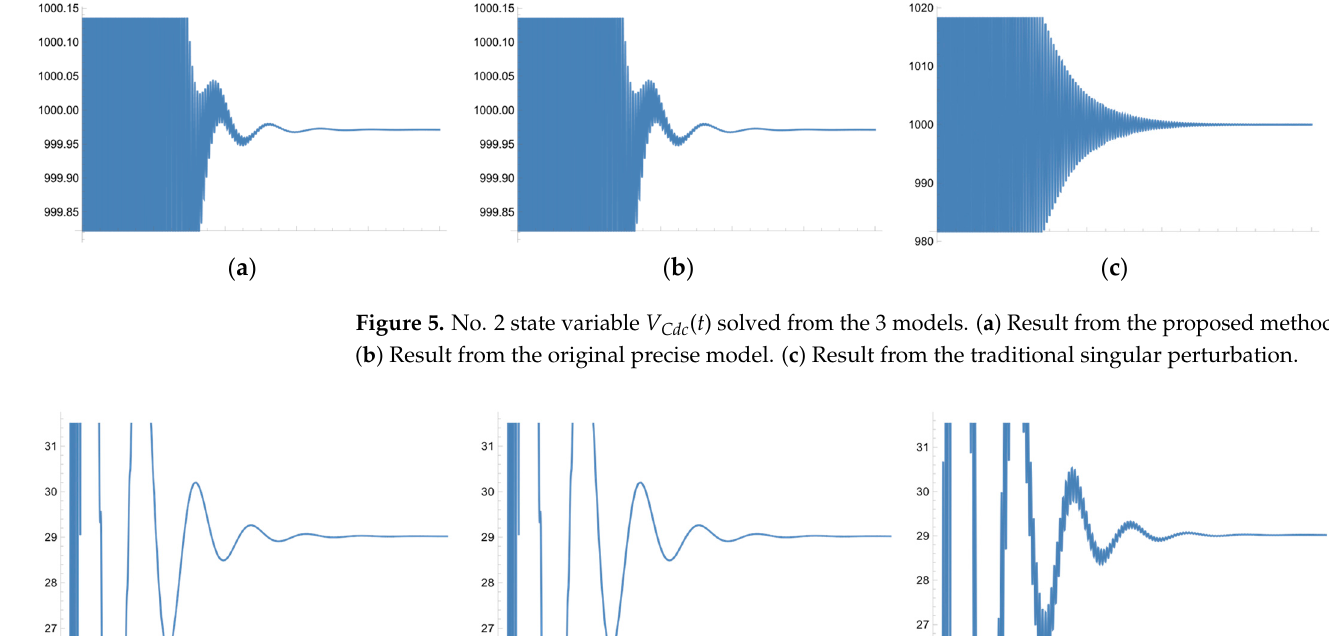
Figure 6. No. 4 state variable P 1 ( t ) solved from the 3 models. ( a ) Result from the proposed method, ( b ) Result from the original precise model. ( c ) Result from the traditional singular perturbation.